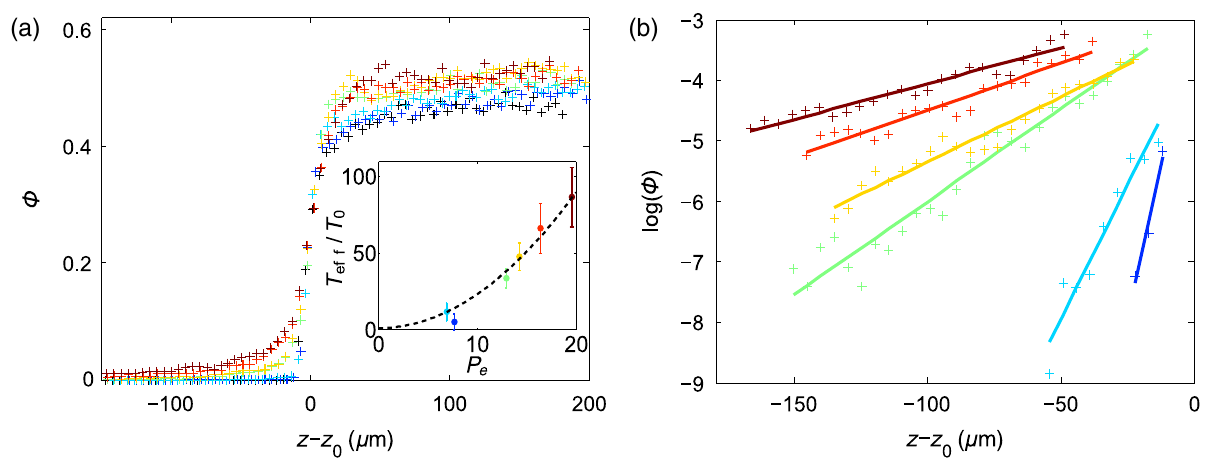
FIG. 2. Experimental density profiles. (a) Density profiles for various activities, arbitrarily shifted horizontally so that z 0 corresponds to ϕ ¼ 0 . 2 . Inset: Evolution of T as a function of the Péclet number, together with the theoretical expectation T eff (b) Zoom-in on the dilute phase ϕ ≪ 1 using a semilog scale, with the associated exponential fit, from which we extract the value of the effective